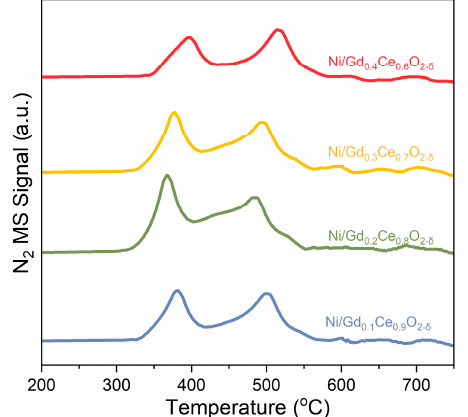
Figure 9. N 2 formation profiles derived from NH 3 -TPSR measurement over Ni/Gd x Ce 1-x O 2- δ cata- lysts.